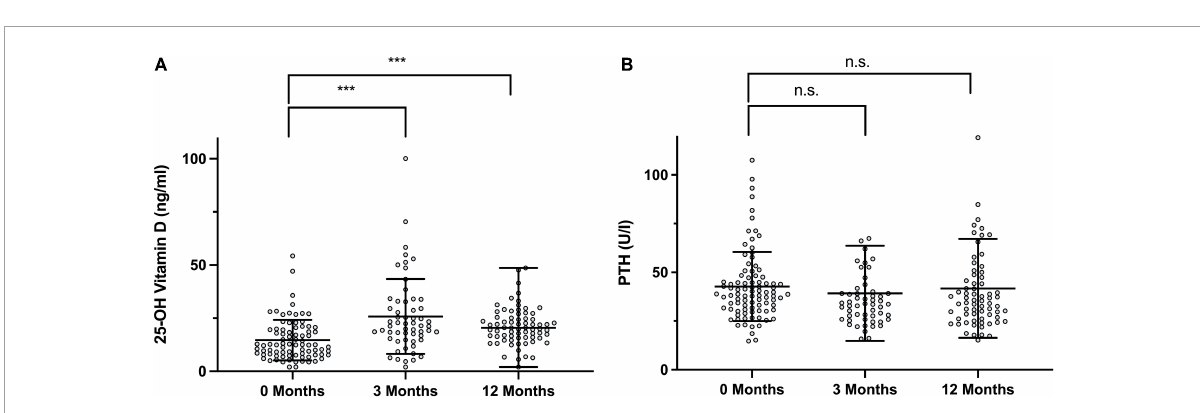
FIGURE4 Longitudinal Follow Up of 25-hydroxy vitamin D and PTH levels. (A) Vitamin D at the initial visit, after 3 months and after 12 months (+12 M). (B) Parathyroid hormone (PTH) at the respective time points. Statistically significant differences between the groups, determined by Mann–Whitney test, are indicated with asterisks (*** P <